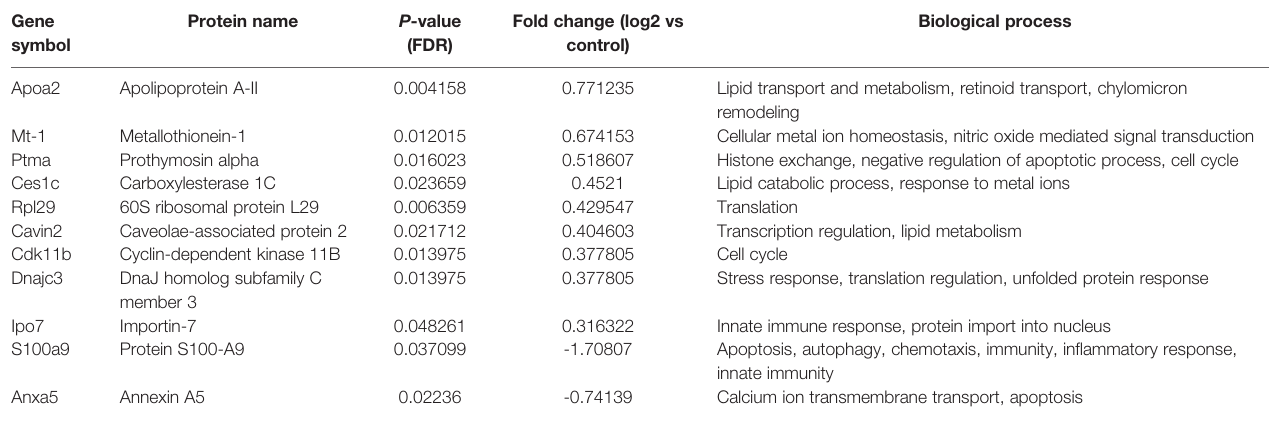
TABLE 3 | List of differentially regulated proteins in 5-FU treated group vs control group. Positive fold-change value denotes up-accumulation and negative fold change value denotes down-accumulation in comparison with control. Gene